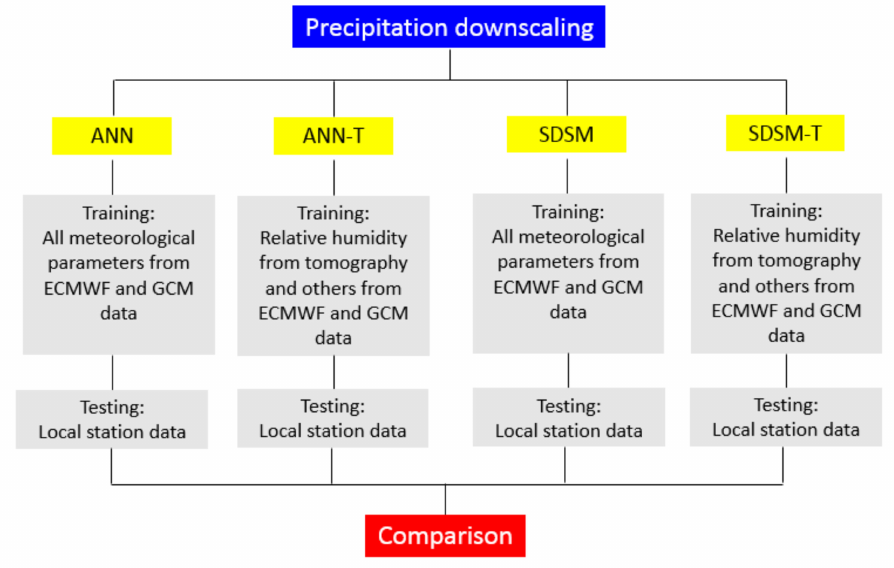
Figure 5. A simple process flowchart of this